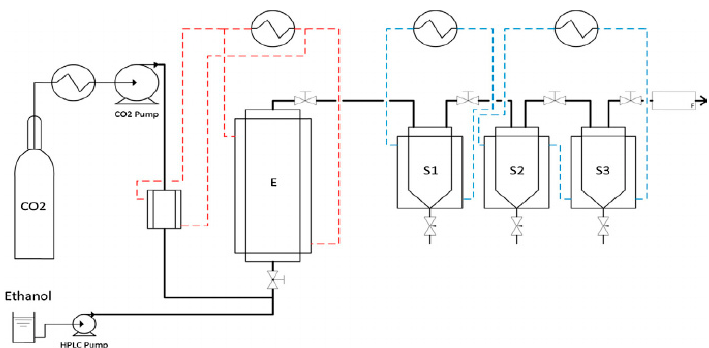
Figure 1. Fluid extraction and fractionation unit schematic drawing. E: Extractor; S1, S2, S3: Separators [34].